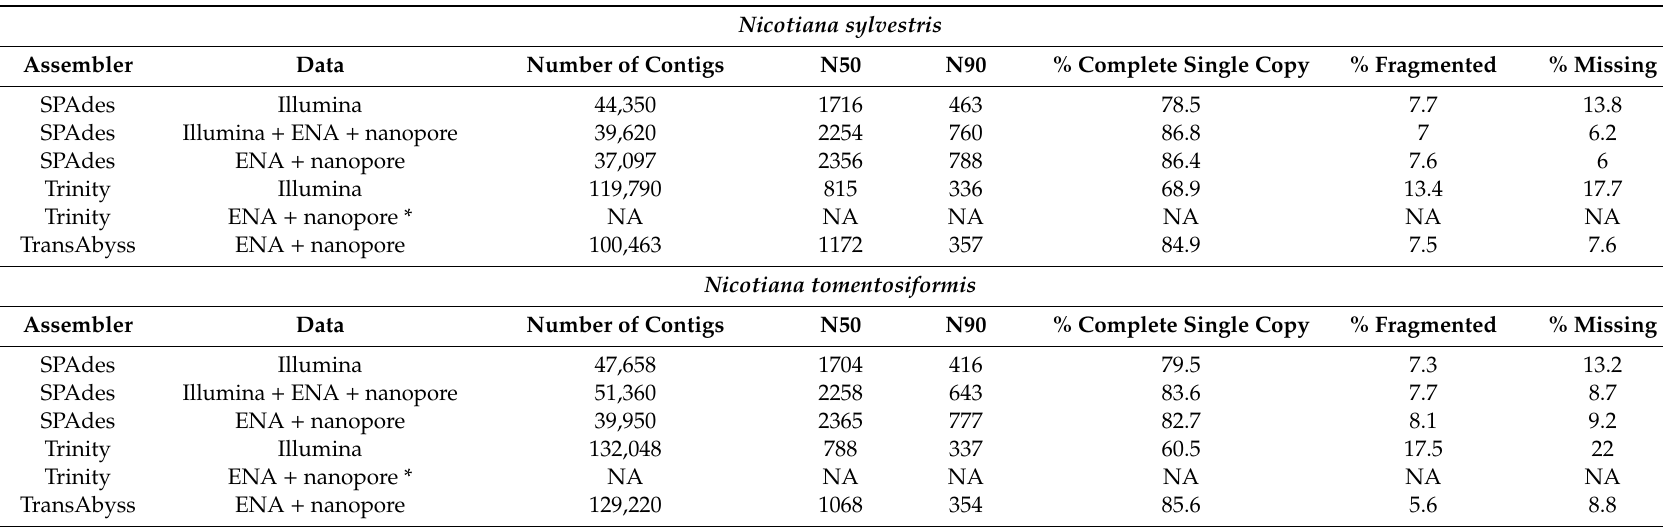
Table 5. Assembly statistics for each transcriptome assembly performed for N. sylvestris and N. tomentosiformis including the assembler used, data that went into the assembly, number of contigs, N50, N90, percent complete single-copy BUSCO genes, percent fragmented BUSCO genes, and percent missing BUSCO